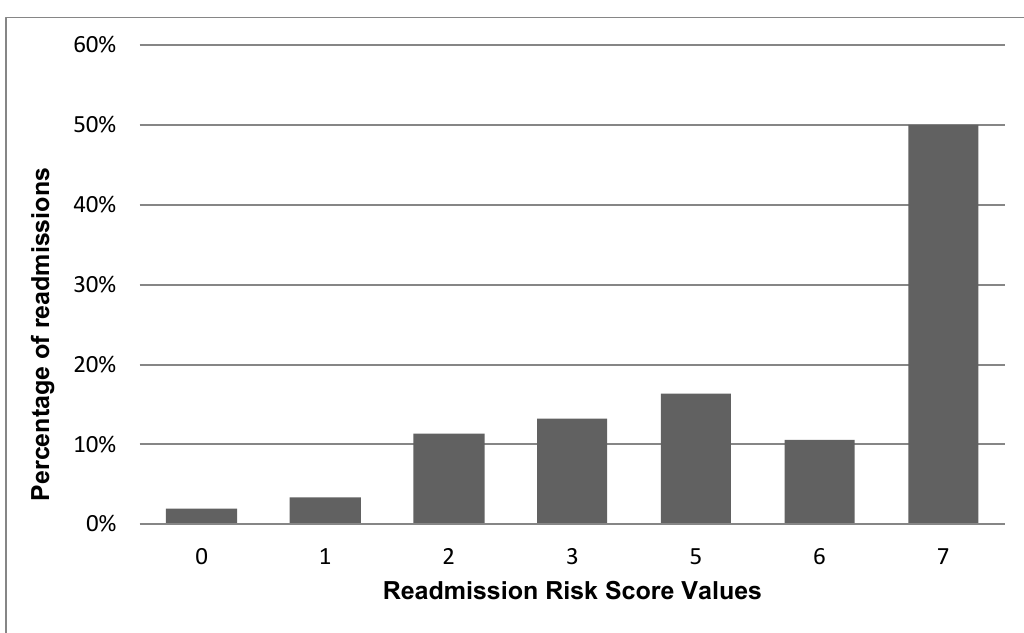
FIGURE 2 - Percentage of patients readmitted according to the Readmission Risk Score value.